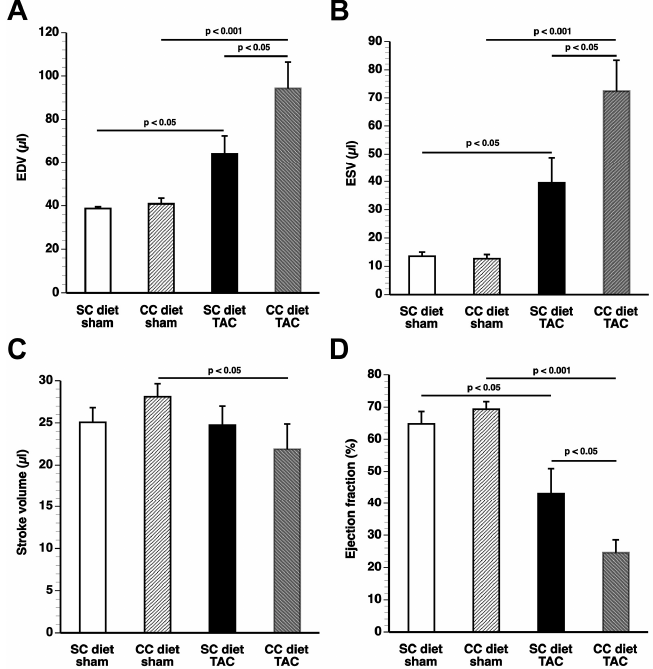
Figure 6. Quantification of ( A ) end-diastolic volume (EDV), ( B ) end-systolic volume (ESV), ( C ) stroke volume, and ( D ) ejection fraction in sham mice and TAC mice by electrocardiography (ECG)-gated micro-PET. The CC diet was initiated at the age of 12 weeks. Sham operation or TAC was performed at the age of 17 weeks. ECG-gated PET imaging was performed eight weeks later. Data represent means ± SEM ( n = 16).